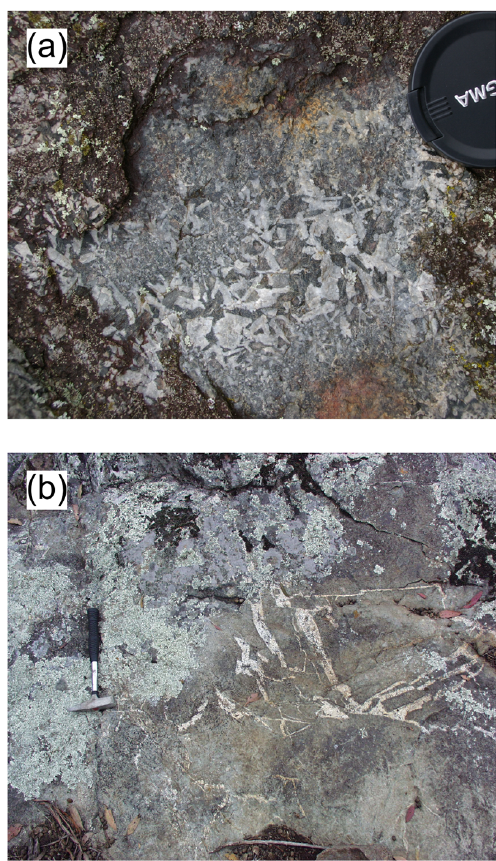
Figure 2. Photos of the Days Creek Gabbro showing (a) massive gabbro enclosing domain of gabbro pegmatite. Camera lens has a diameter of 5cm; (b) finer-grained dolerite pluton margin hosting felsic veins. Hammer length